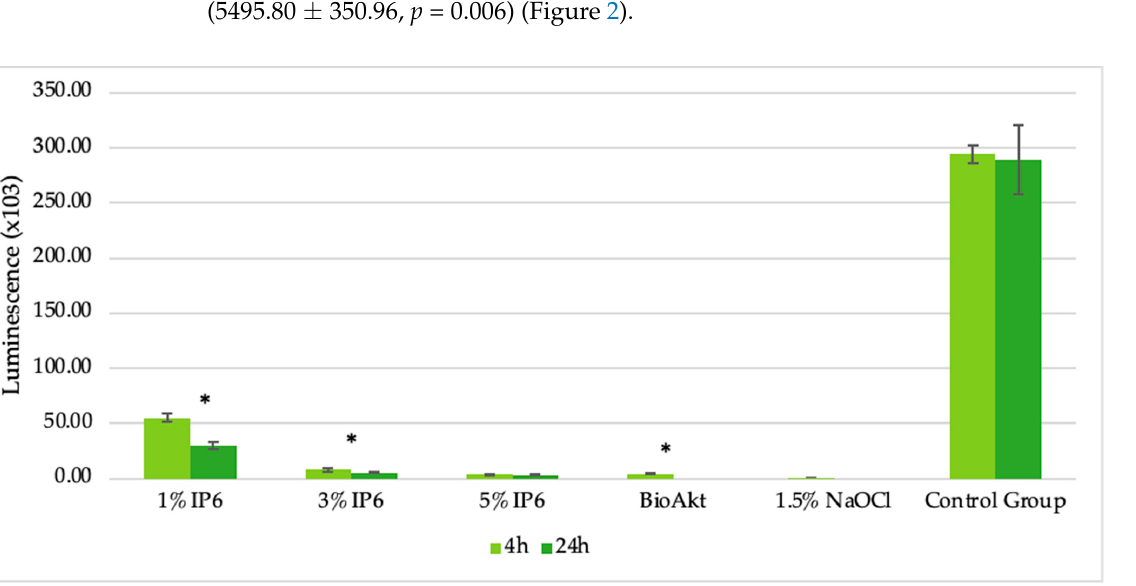
Figure 1. Crystal Violet Assay Results; * indicates statistically significant difference between 4 h and 24 h.